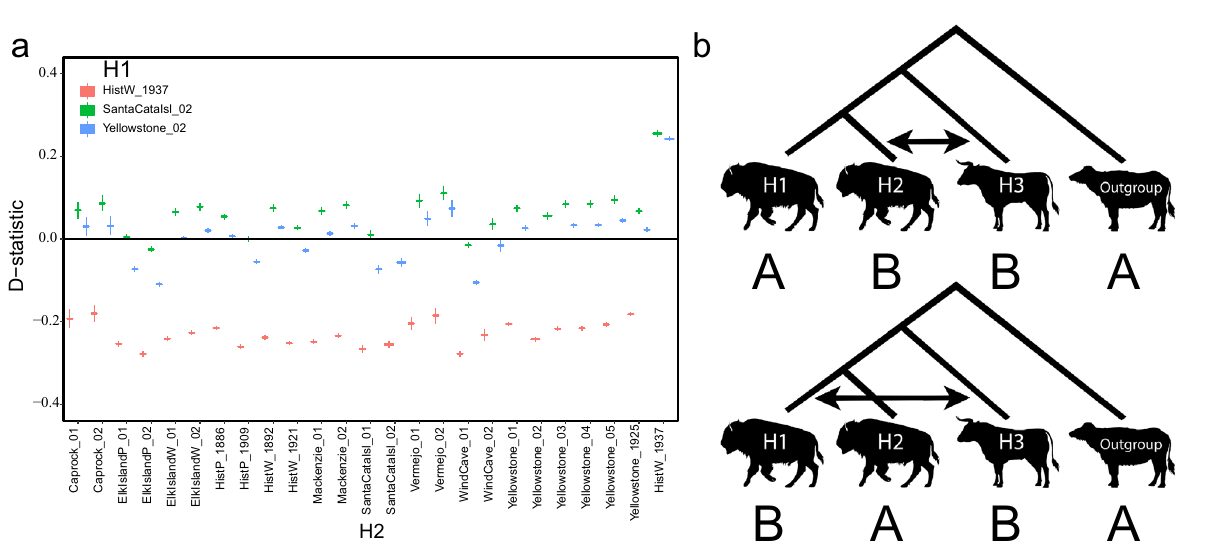
Figure 4. ( a ) D-statistics from individual level all-to-all comparisons of ancestral and derived allele frequencies. Negative D-statistic indicates that H1 (bison) is closer to H3 (Angus cattle) then H2 (bison). ( b ) Phylogenetic tree to show potential gene flow between B. taurus (H3) and B. bison (H1) or B. bison